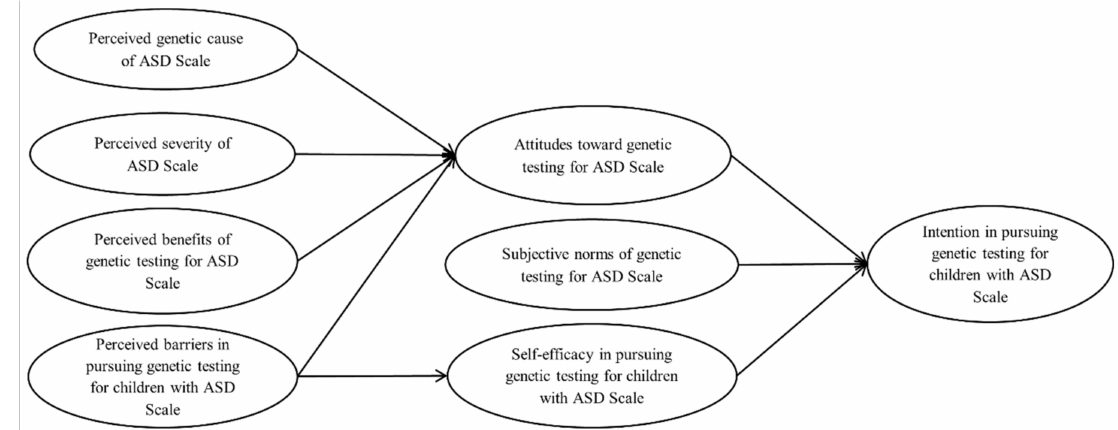
Figure 1. The integrated theoretical framework for the parental intention in pursuing genetic testing for their children with Autism Spectrum Disorder